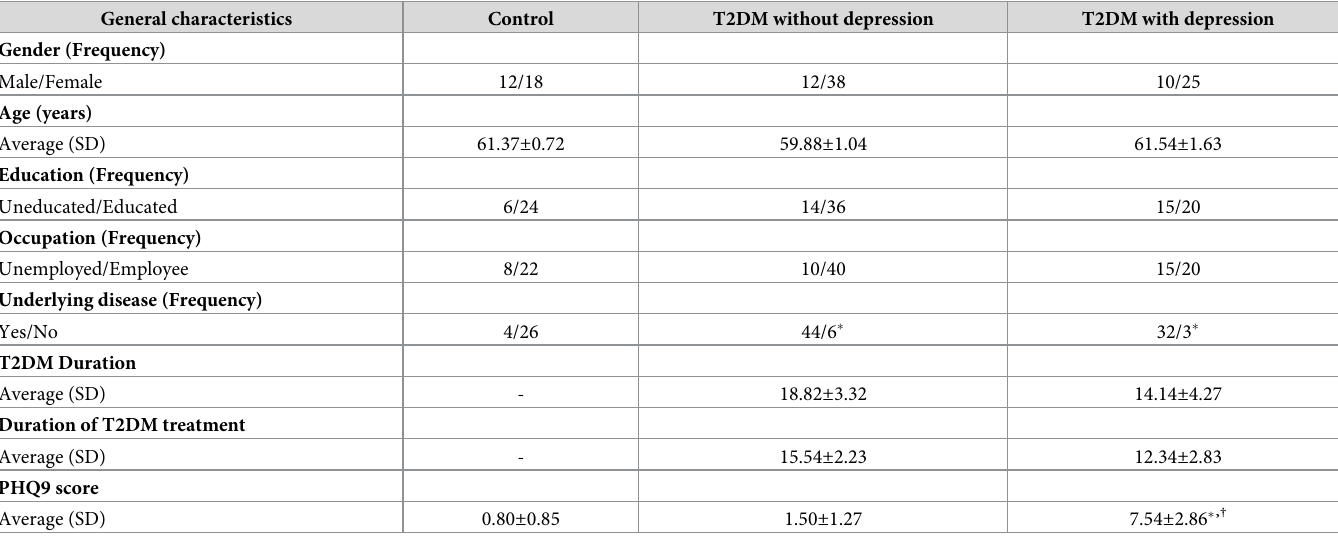
Table 1. General characteristics of the control, type 2 diabetes, and type 2 diabetes with depression groups. General